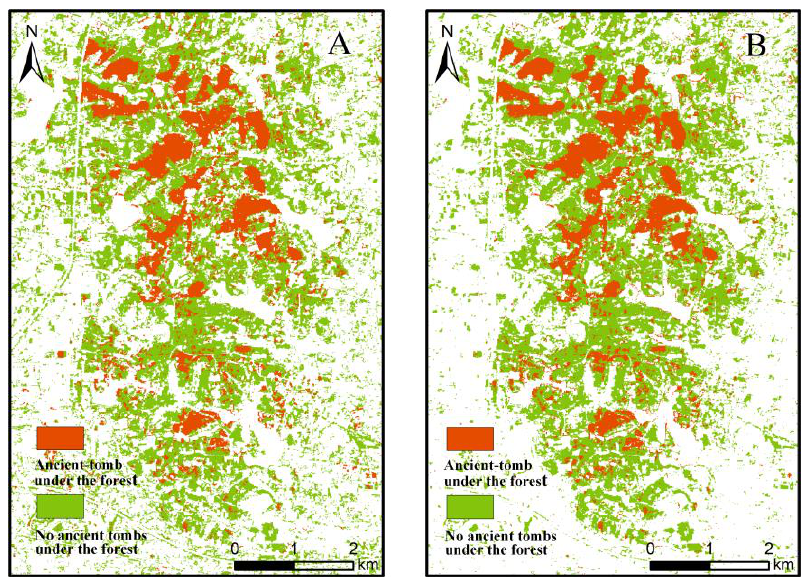
Figure 14. Spatial distribution identification of ancient tombs under the forest in Baling Mountain. ( A ) Result of combination 1. ( B ) Result of combination 2. Although the spatial distribution of the